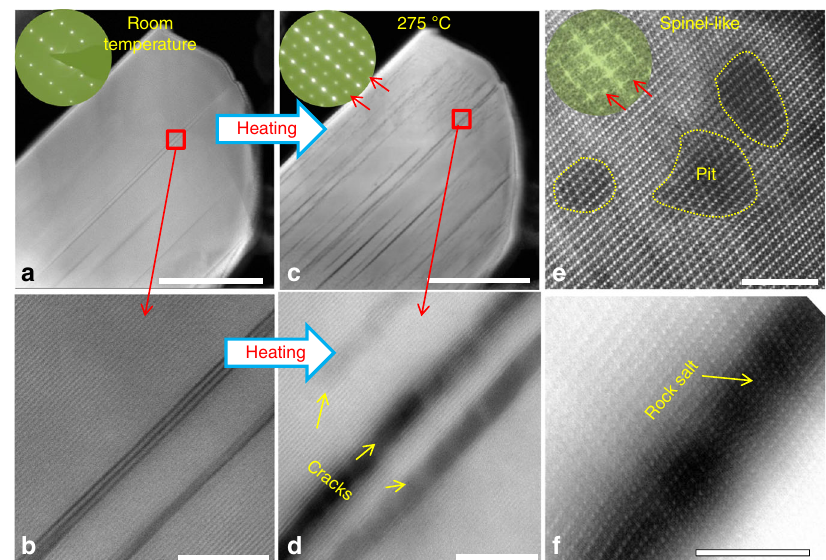
Fig. 3 In situ heating-induced crack nucleation and propagation. The LiNi 0.6 Mn 0.2 Co 0.2 O 2 (NMC622) was delithiated by charging to 4.7 V vs. Li metal. a and b High angle annular dark fi eld (HAADF) images from delithiated NMC622 before heating (room temperature). c – f HAADF images after heating to 275 °C. Selected area electron diffraction (SAED) patterns and fast Fourier transformation images in ( a ), ( c ), and ( e ) show the overall lattice change during heating. d , e , and f show local lattice structure change at crack regions and crack-free regions. The scale bars are 200 nm in ( a ) and ( c ); 10 nm in ( b ) and ( d ); and 4 nm in ( e ) and ( f